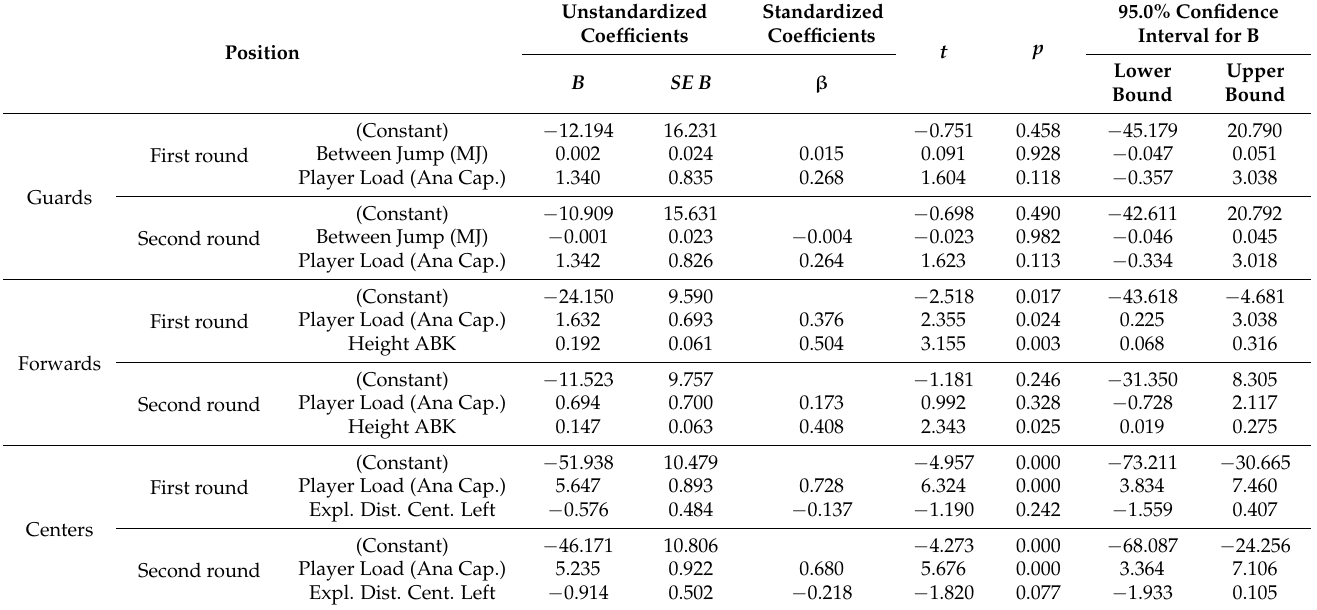
Table 8. Parameter